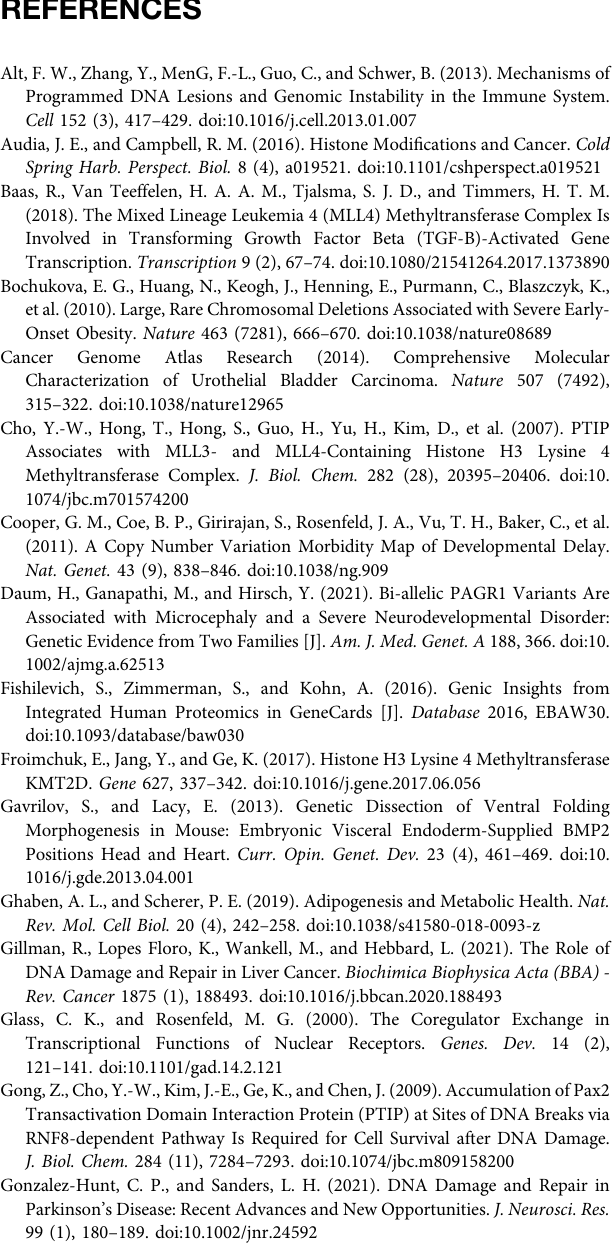
Supplementary Figure S1 | The expression pro fi le of PA1 in human tissues according to the GeneCards database.